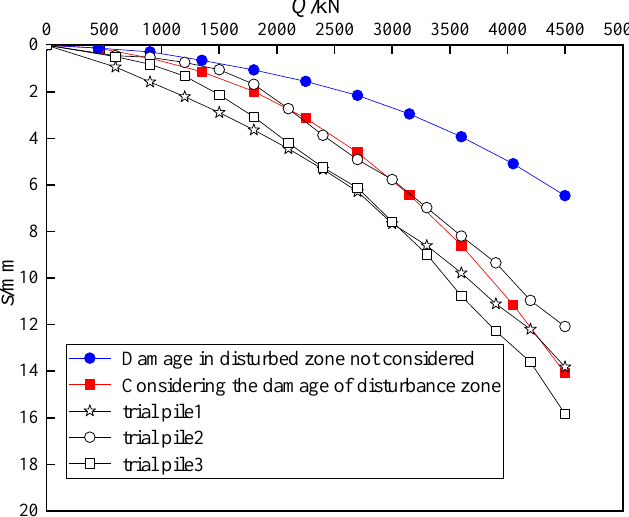
Figure 13. The comparison of numerical simulation and measured load-settlement curves.